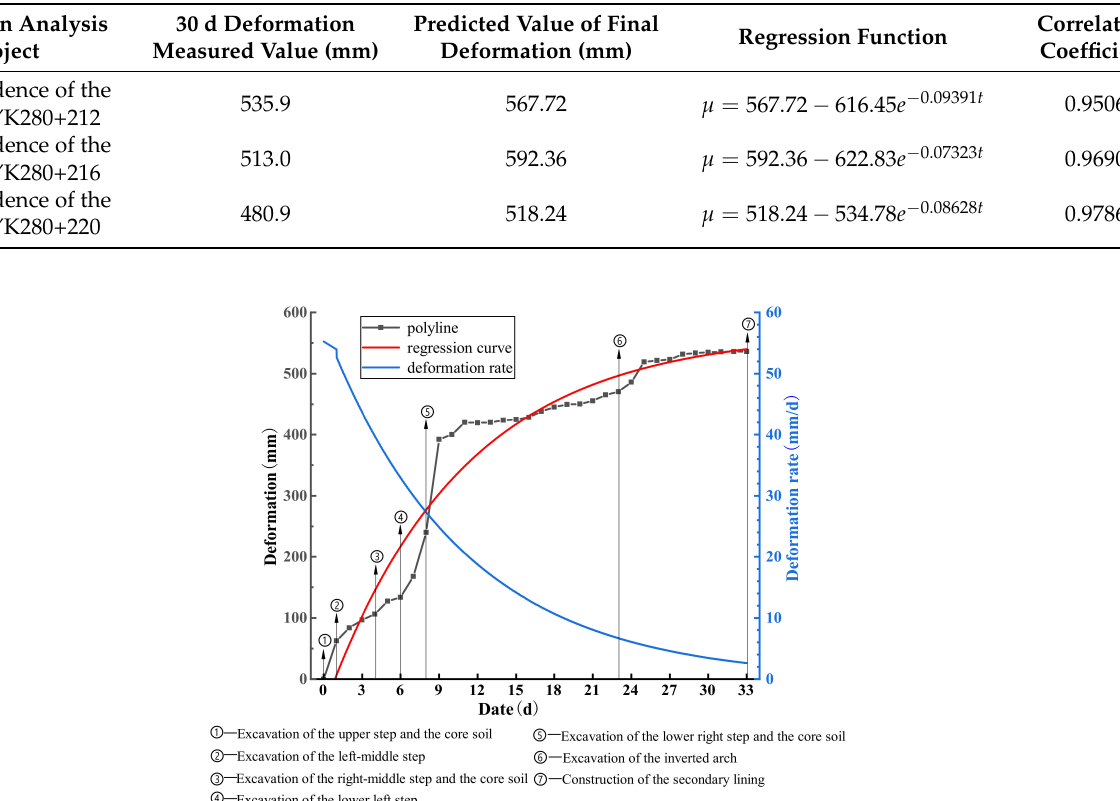
Table 4. Deformation regression analysis results.